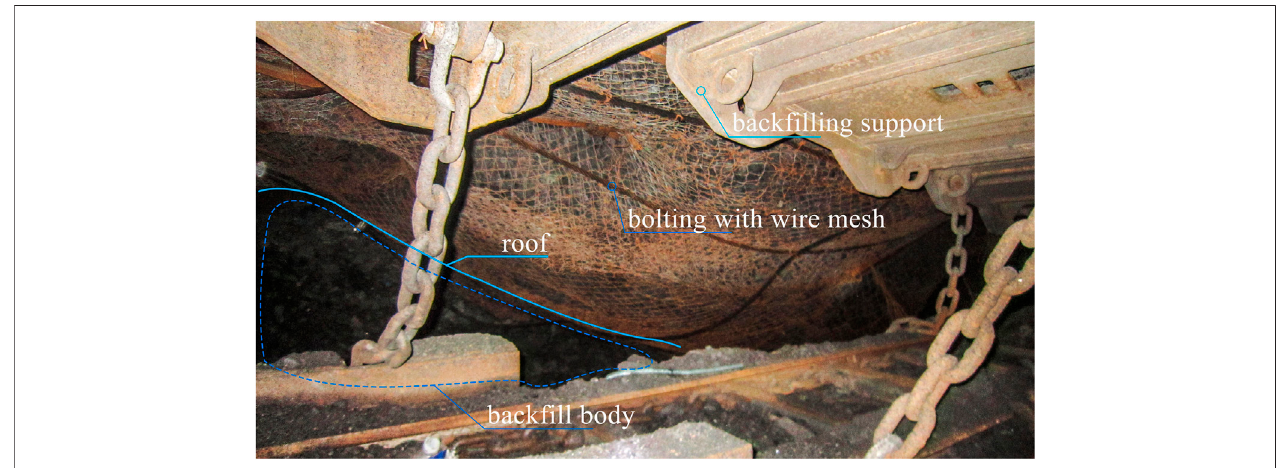
FIGURE 15 | Working face of fi lling